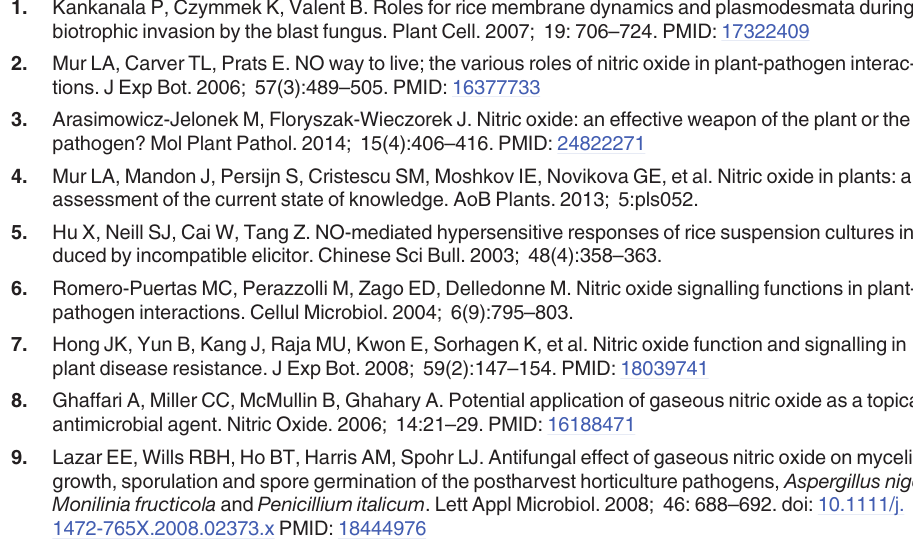
S1 Table. Primers used in this